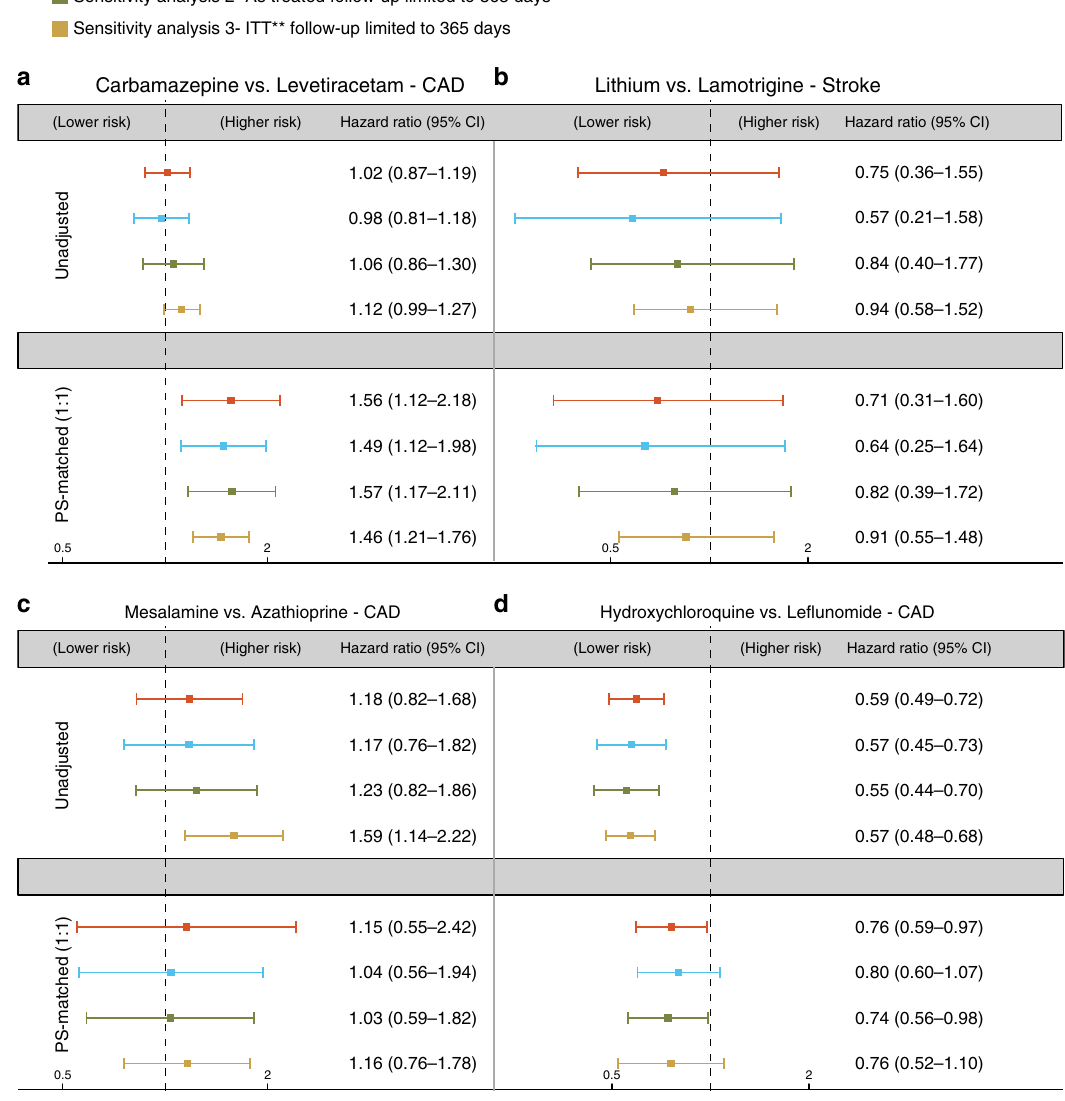
Fig. 3 Hazard ratios and 95% con fi dence intervals for four cohort studies. Four cohort studies were performed using the pooled data from four drug pairs ( a - d ) Truven MarketScan and Optum Clinformatics databases (Methods section). In the primary analysis approach (as-treated), follow-up was stopped upon discontinuation of the index medication. Follow-up assumptions were varied in three sensitivity analyses to: (1) exclude the fi rst 60 days of follow-up to reduce unmeasured baseline confounding, (2) truncate the follow-up to 1-year to minimize time-varying confounding, and (3) continue the follow-up for characteristics; all analyses were conducted separately in two databases and results were pooled using the DerSimonian and Laird random effects model with inverse variance weights. * In the as-treated approach, the follow-up was stopped if patients either fi lled a prescription for a drug in the other